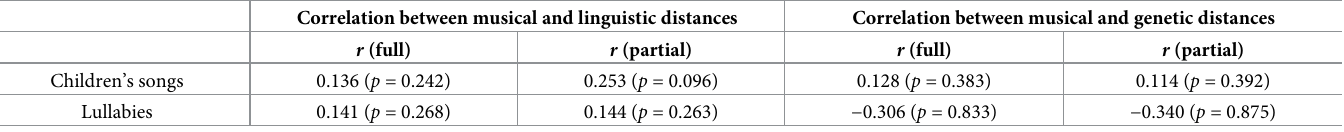
Table 5. Full and partial correlation coefficients between musical and linguistic distances and between musical and genetic distances among ten and five islands, respectively (see Table 4) for children’s songs and lullabies, which are subsets of the "child" songs. Correlation between musical and linguistic distances Correlation between musical and genetic